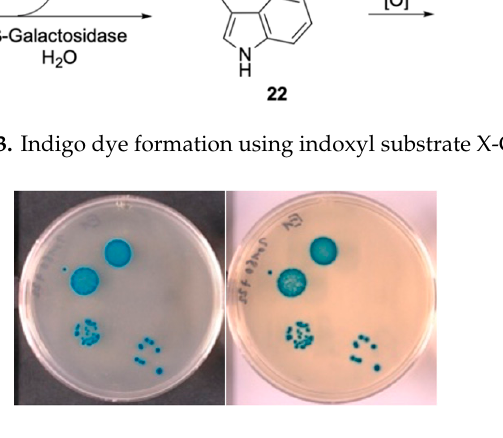
Figure 4. Colonies of E. coli on a plate containing X-Gal. Pictures kindly supplied by Dr Julian Ihssen, Biosynth Carbosynth.